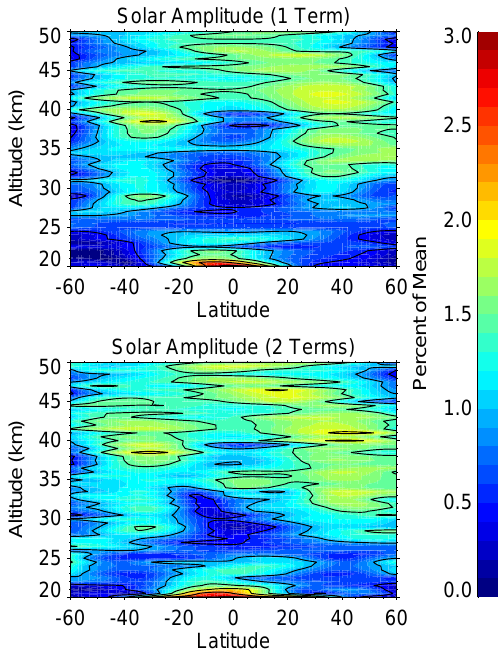
Figure 8. Amplitude of oscillation of the solar term as a percentage of the local mean for the use of one and two solar proxy terms while including a volcanic term. Contour lines are plotted at intervals of 0.5%.